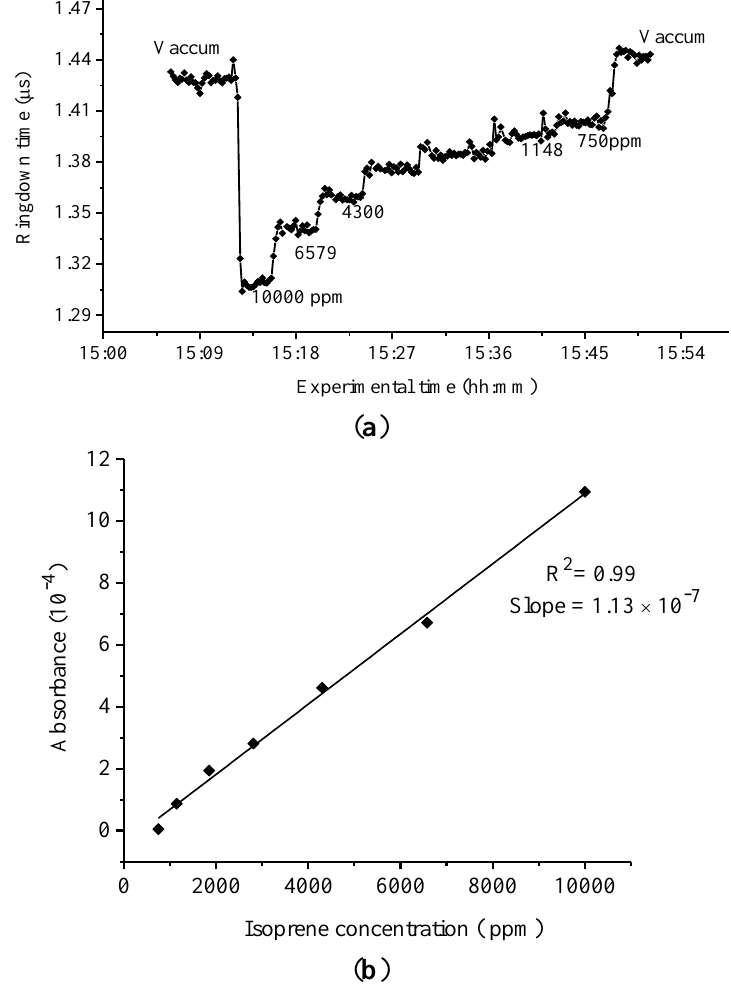
Figure 4. ( a ) Ringdown absorption graph for isoprene at 275 nm ( b ) Corresponding curve of the absorbance versus